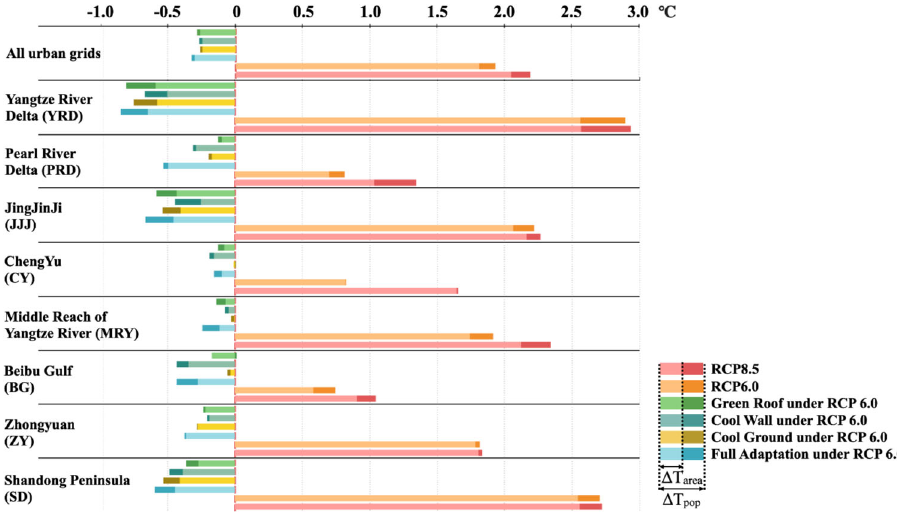
Fig. 2 Δ T area and Δ T pop resulting from future changes and individual adaptation strategies. Δ T area denotes the average change without considering the distribution of urban residents. Δ T pop denotes the risk change incorporating the distribution of residents, which is obtained by weighting the local average heat level by the corresponding number of urban residents within all urban grids.